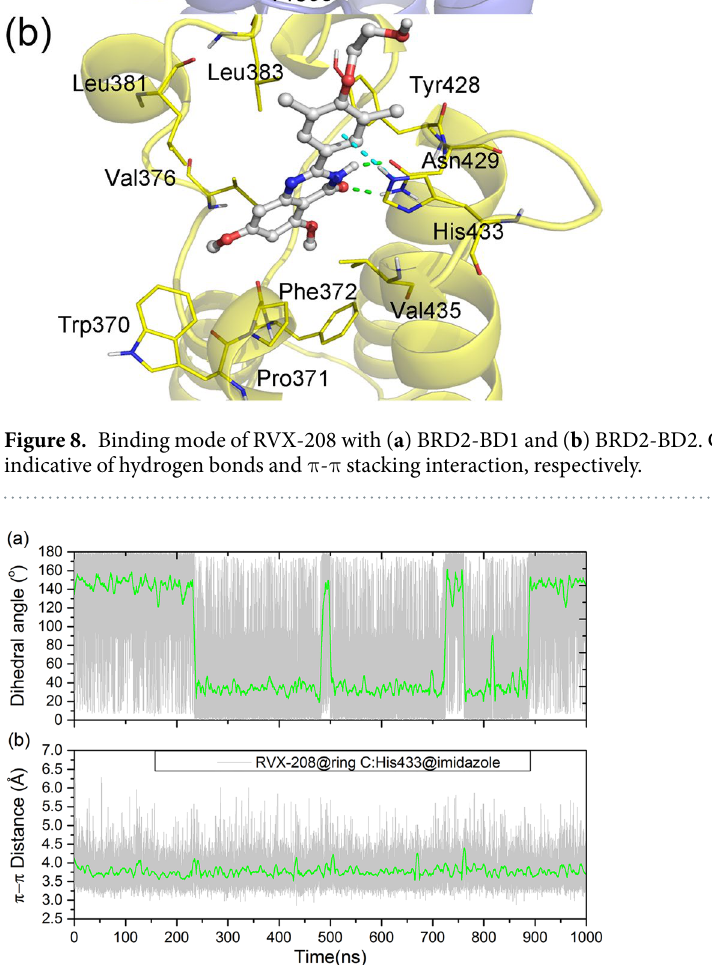
Figure 9. The monitored ( a ) dihedral angle and ( b ) distance between ring C of RVX-208 and imidazole ring of His433 of BRD2-BD2 during the